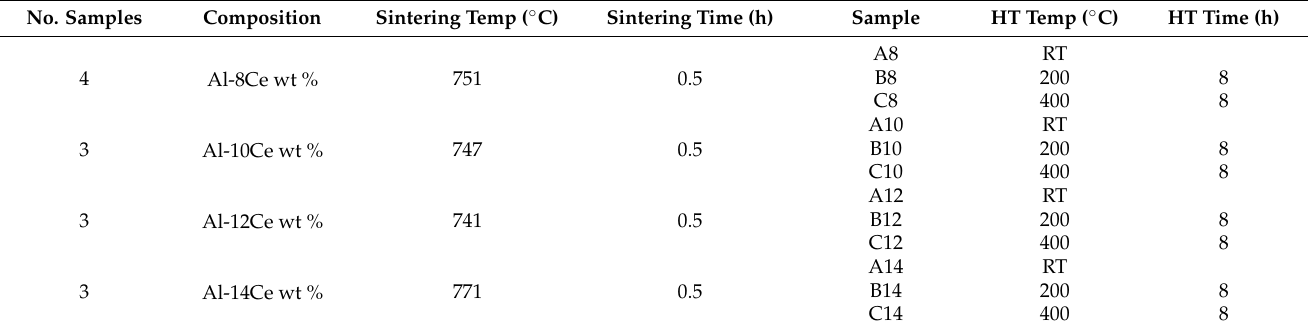
Table A1. Test matrix PIT Al-xCe wt % elemental powder